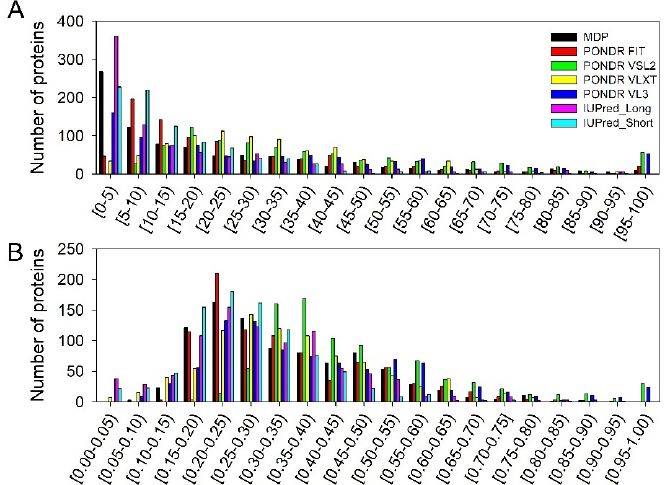
Figure 6. Distribution of the Heslington brain proteins based on their PPIDR ( A ) and MDS ( B ) values evaluated by various per ‐ residue disorder predictors utilized in this study.